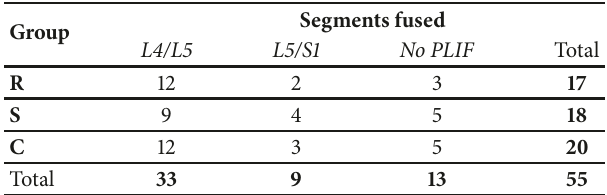
Table 1: Patients with circumferential fusion presented per group and level of PLIF insertion.